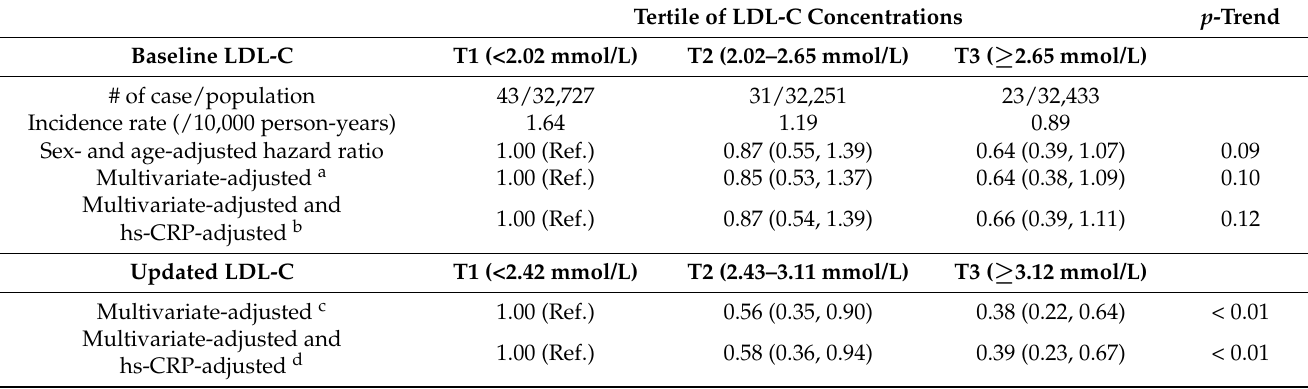
Table 2. Adjusted hazard ratios and 95% confidence intervals for risk of rheumatoid arthritis by low-density lipoprotein cholesterol concentration. Tertile of LDL-C Concentrations p